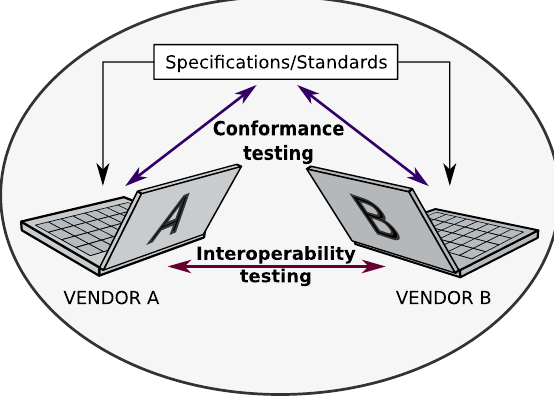
Figure 16. Peer-to-peer interoperability testing: independent implementations get connected and their cooperation is evaluated, including verification of exchanged messages (formats and